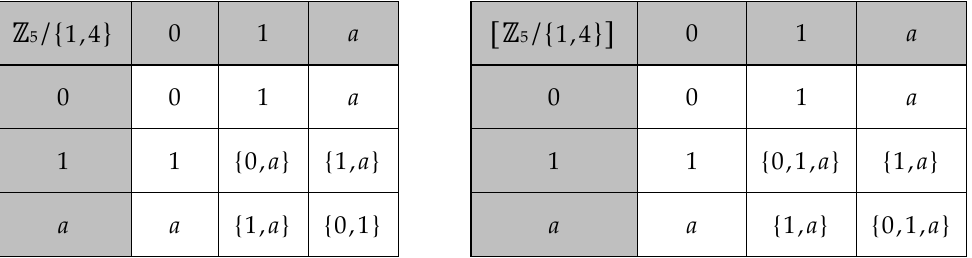
Table 4. The Cayley table of the canonical hypergroup of the hyperfield 𝐹/𝐹 + . 0 − 1 1